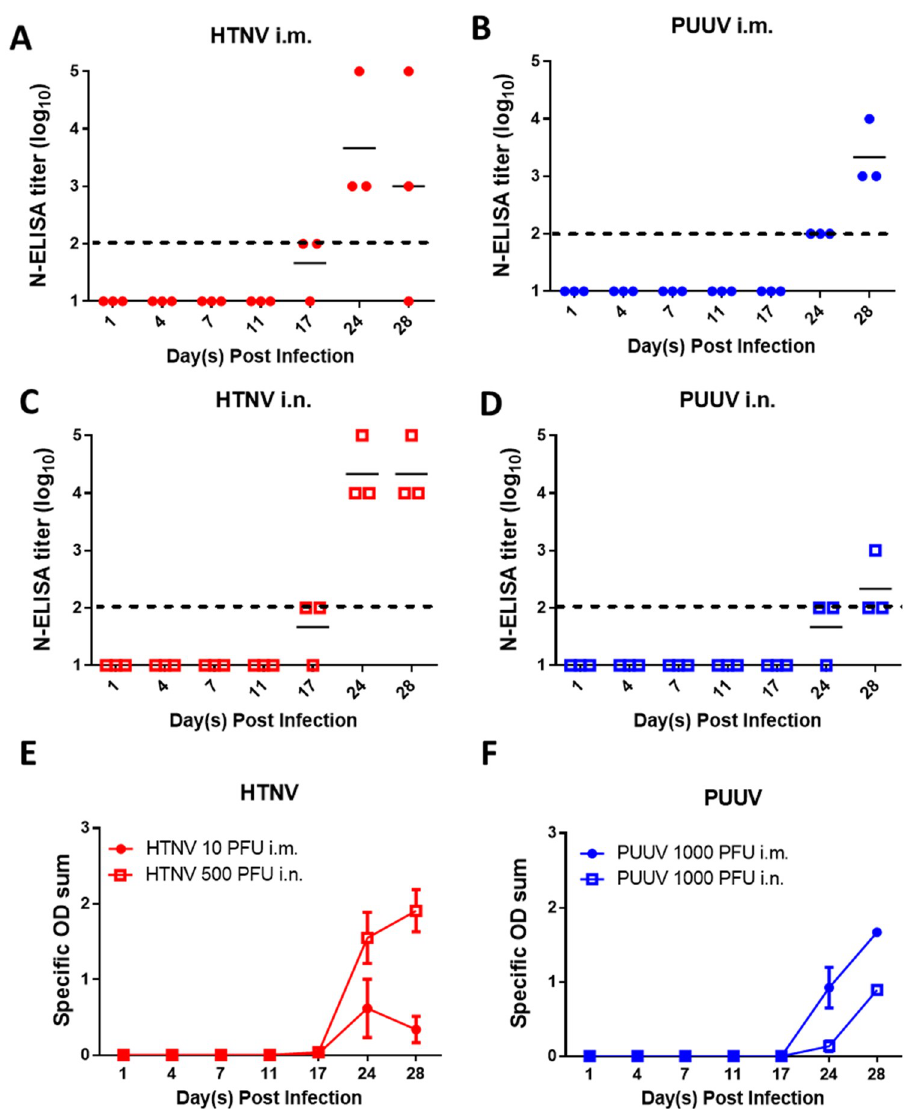
Fig 2. Kinetics of seroconversion in low dose hamster models. Syrian hamsters were infected either 10 PFU HTNV i. m., 500 PFU HTNV i.n., 1000 PFU PUUV i.m., or 1000 PFU PUUV i.n. Hamsters were terminally bled at various points post infection and N-ELISA endpoint titers (log 10 ) were used to determine infection status. The mean titer (A-D), and specific OD sum ± standard error of the mean (SEM) (E-F) for the N-ELISA is displayed for each group. The limit of detection (2log 10 ) for the N-ELISA is depicted as a dashed line. The specific OD sum represents the area under the titer curve. of three hamsters on/after Day 11 post infection (Fig 3B). A small amount of viral genome detected in the brain of a PUUV i.n. infected hamster, 28 days post challenge, is the only viral genome detected in any organ at any time point post PUUV i.n. infection (Fig 3F). Serum viremia was detected in hamsters challenged with HTNV i.m. between 11 and 28 days post infection, though the presence of virus was sporadic except for Day 24. Serum vire- mia was only detected in two hamsters challenged with HTNV i.n., one on Day 11 and one on Day 17. No serum viremia was detected in hamsters challenged with PUUV by either route (Fig 3G). Similarly, the presence of viral genome was sporadically detected in the urine of